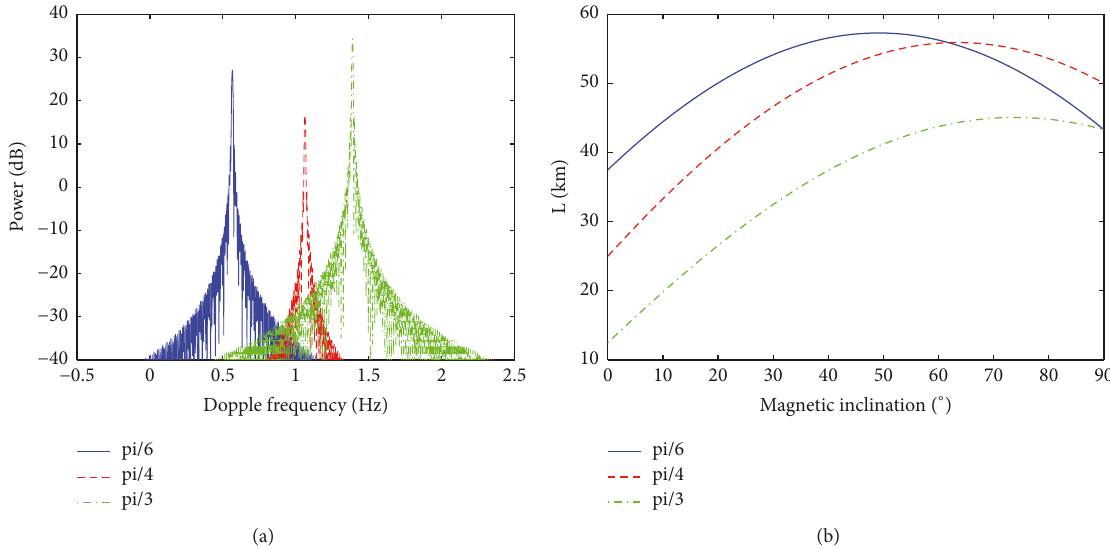
Figure 7: Simulations of oblique backscattering: (a) power with different incidence angles for FMCW. (b) L with different incidence angles.